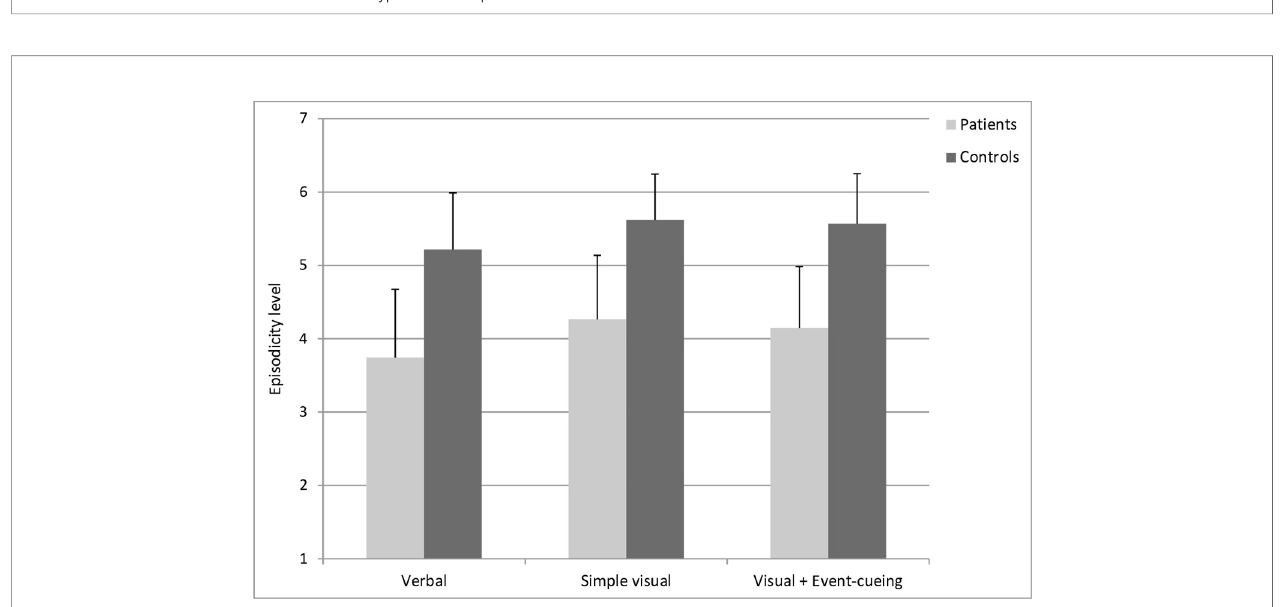
FIGURE 4 | Mean episodicity level (and standard deviations) evaluated by the participants during the cued recall task. These results highlighted lower scores of episodicity in the patient group compared to controls, but no relevant differences across the different types of